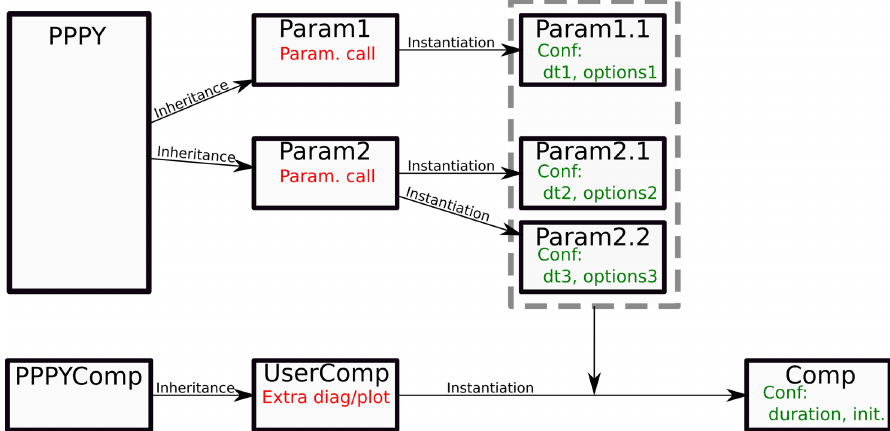
Figure 4. Tool organization diagram. The top six boxes represent the parametrization objects, while the lower three boxes are the comparison